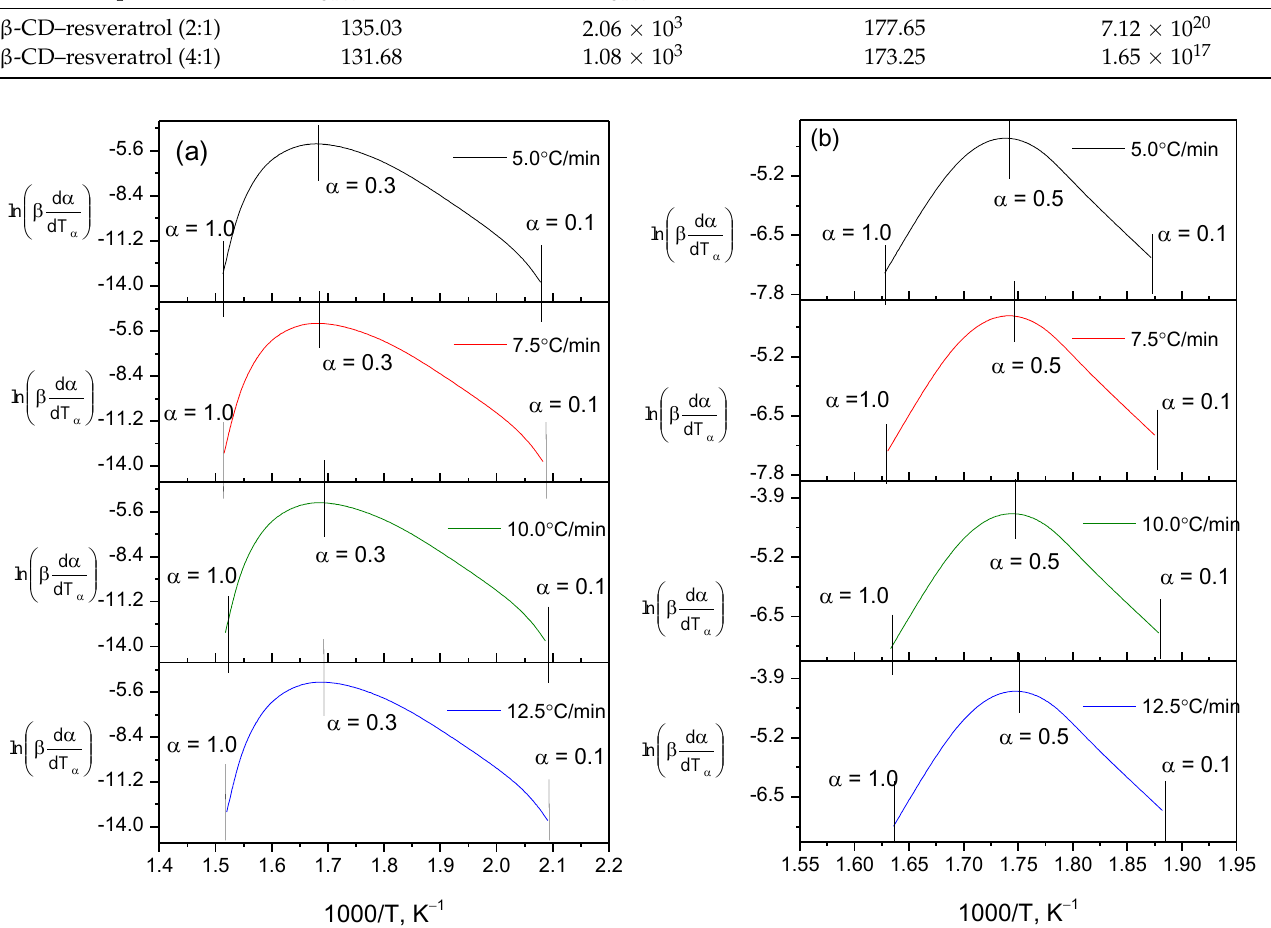
(cid:104) (cid:105) β d α on 1/T, constructed according to thermogravimetric    dTd dT α  ln on 1/T, constructed according to thermogravi-  